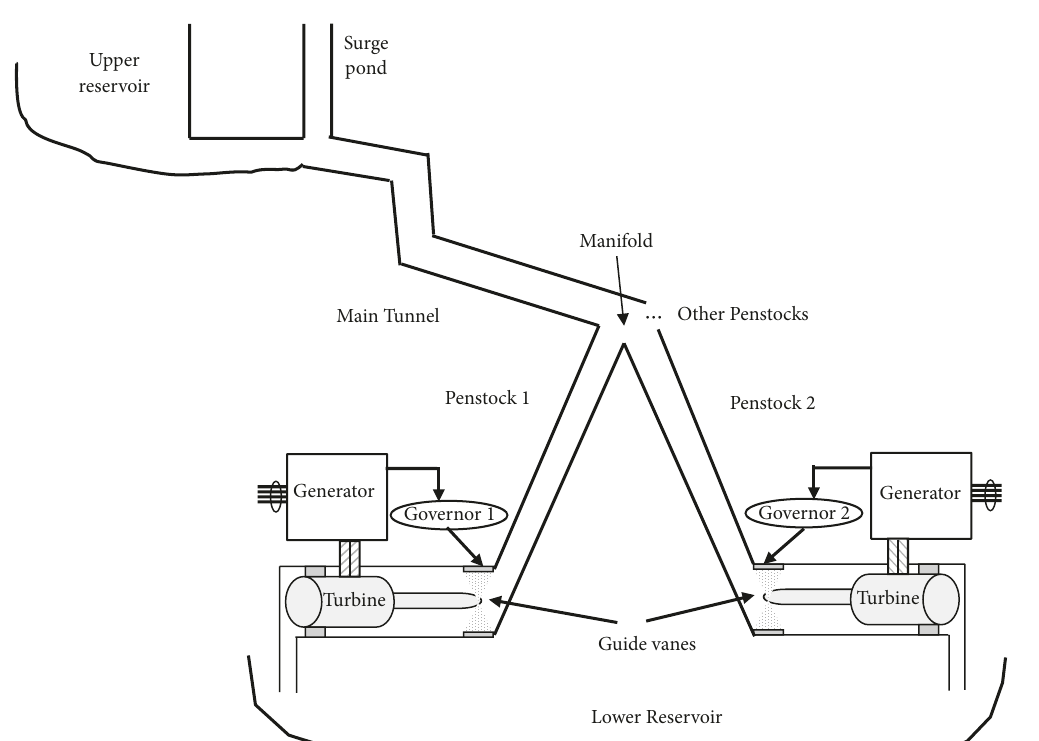
Figure 1: Dinorwig power station’s representation showing only 2 of the 6